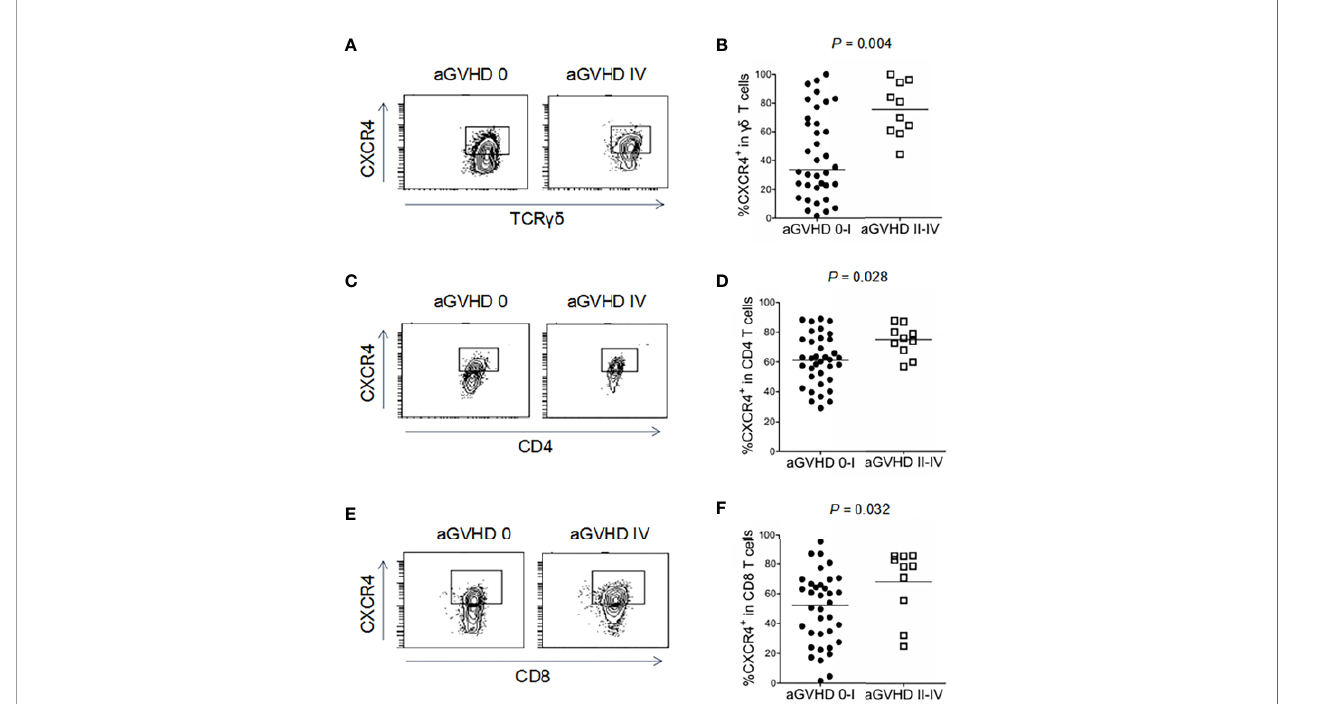
FIGURE 5 | Association of CXCR4 expression in gd T cells, CD4 and CD8 T cells with aGVHD in haploidentical HCT recipients. The proportions of CXCR4 + gd T cells (A, B) , CXCR4 + CD4 T cells (C, D) , and CXCR4 + CD8 T cells (E, F) were detected by fl ow cytometry in recipients with grade 0-I and II-IV aGVHD after haploHCT. P values are shown on the